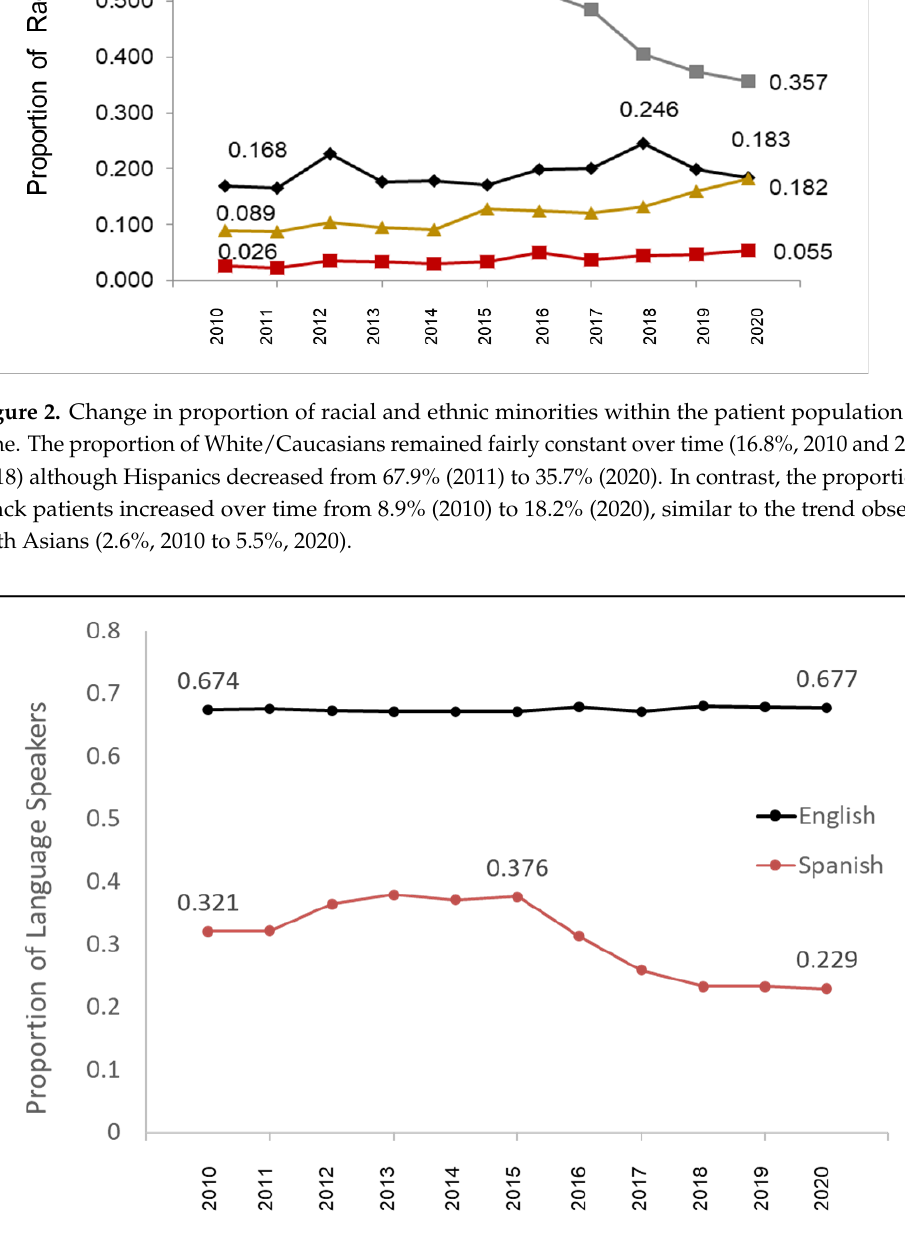
Figure 3. Change in the preferred language spoken over time. The majority of patients speak English as their preferred language, which remained relatively constant over time at approximately 67%. The percentage of patients who speak Spanish declined somewhat over time, decreasing from 32.1% (2010) to 22.9% (2020).